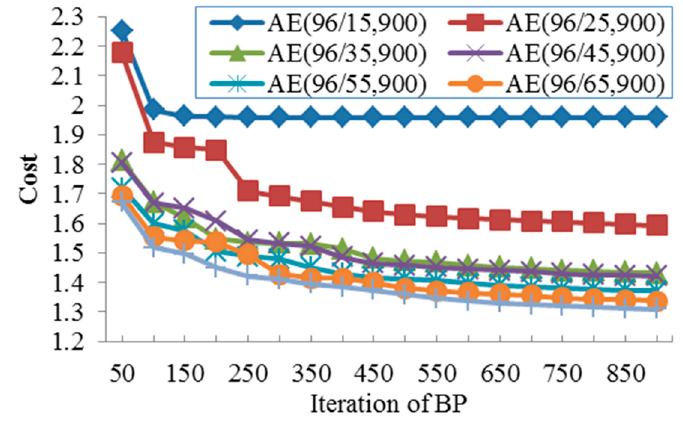
Figure 7. Relationship of the cost, features, and iterations.